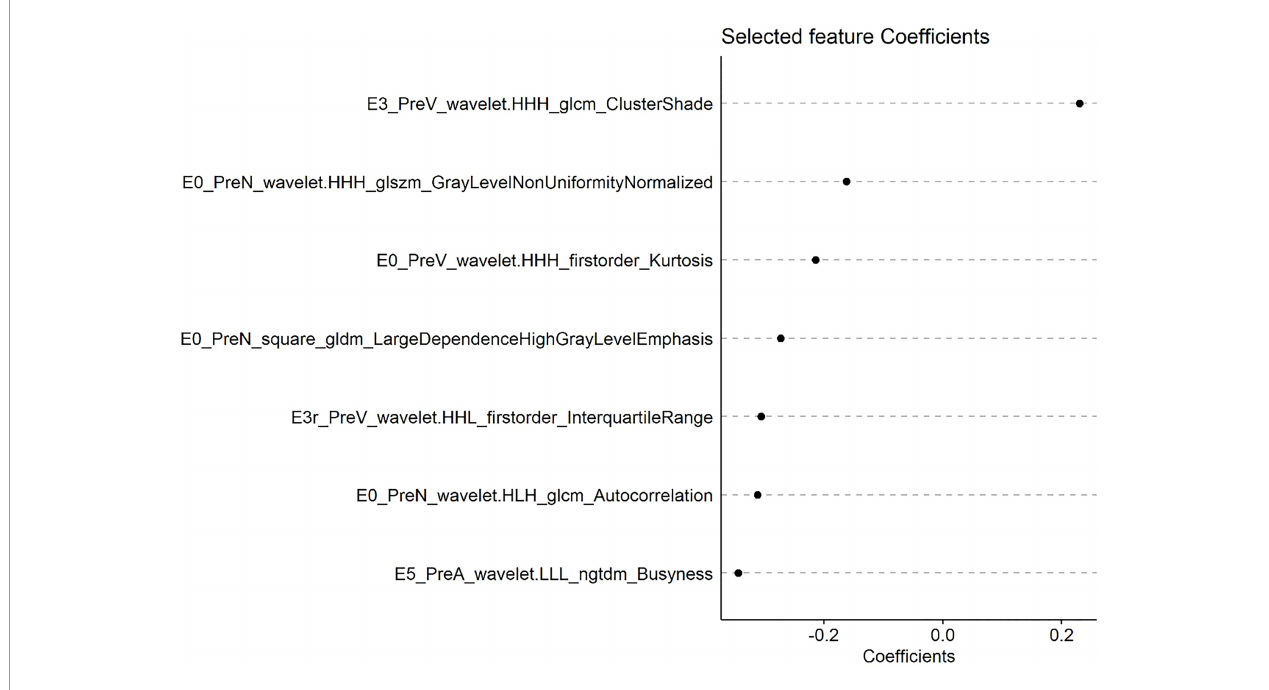
FIGURE 2 | The coef fi cients of each feature based on PreRad